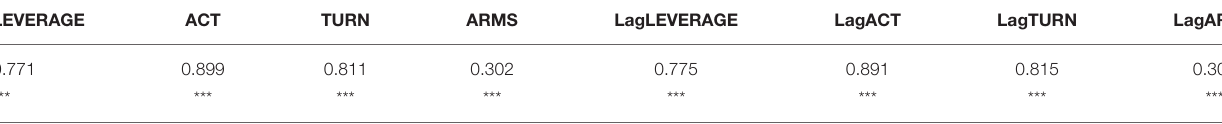
TABLE 1 | The correlation coefficients of the market index SHCOMP and eight primary sentiment indicators. LEVERAGE